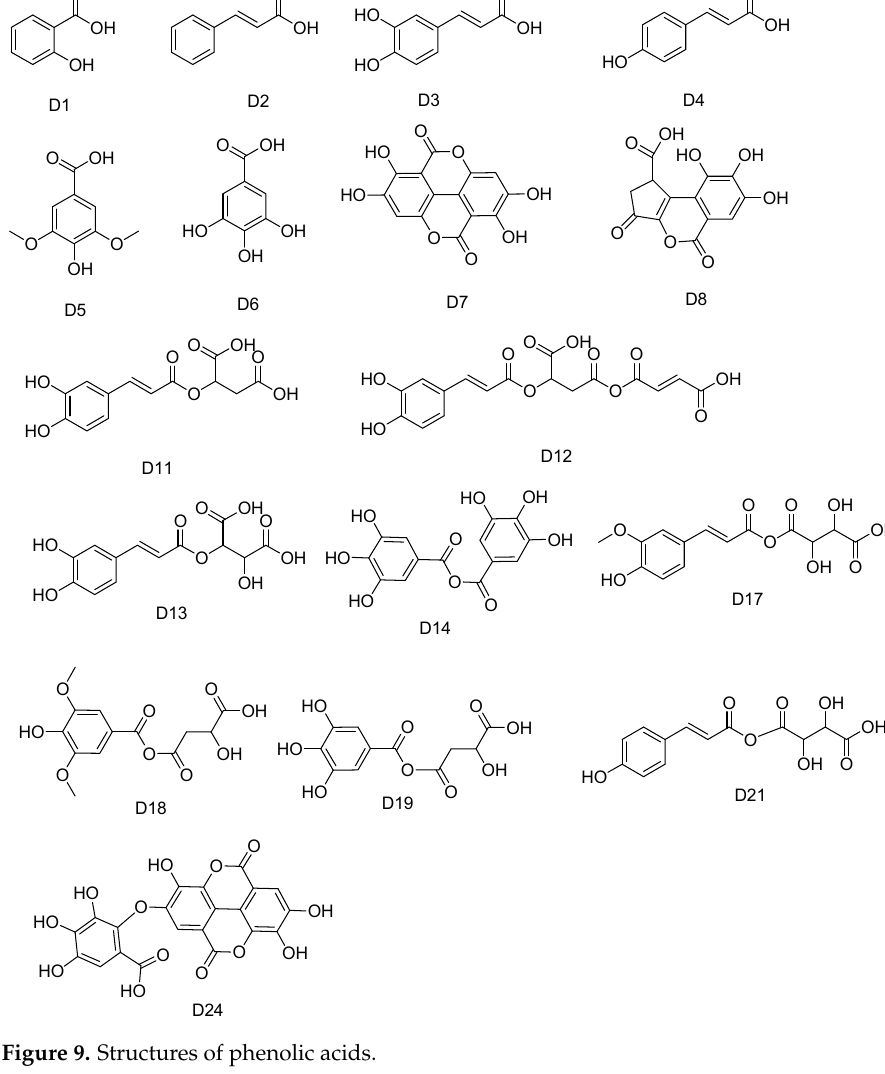
Figure 9. Structures of phenolic acids.